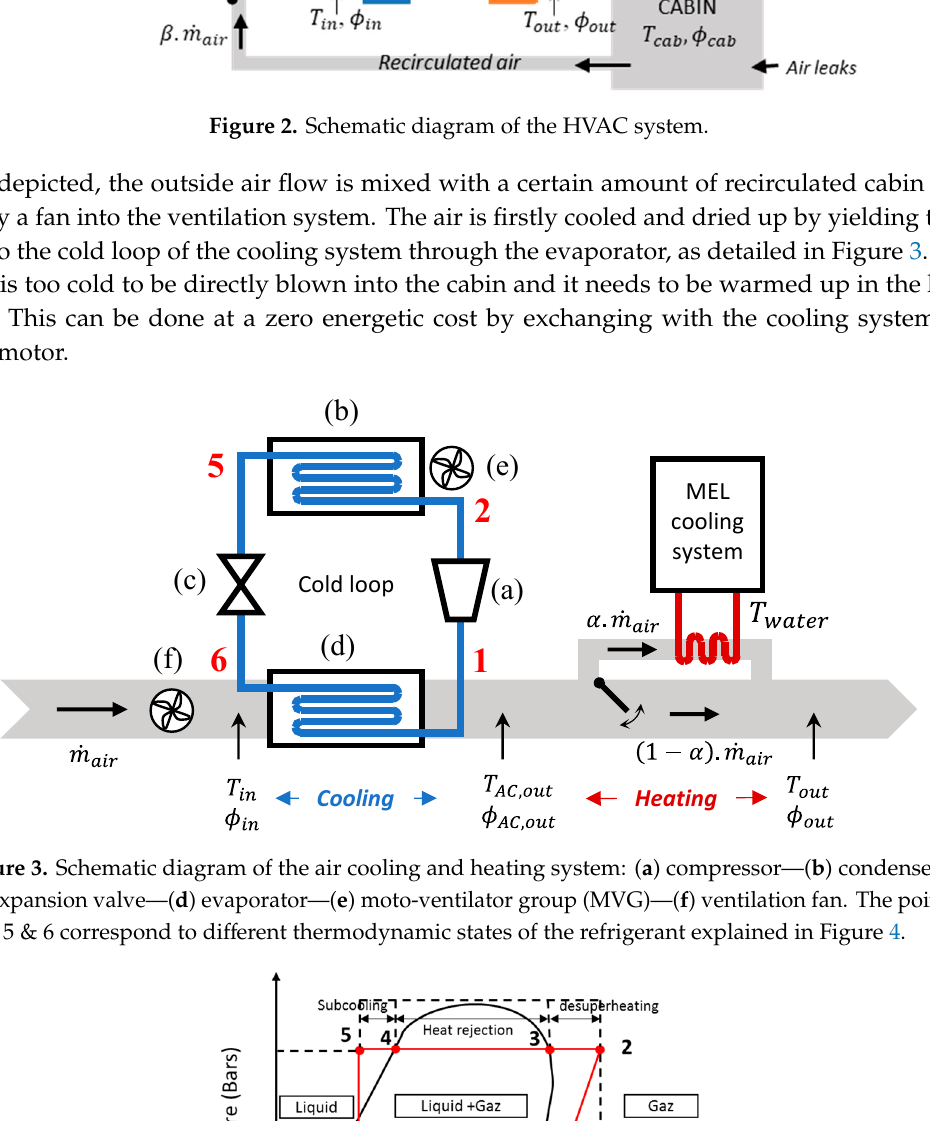
Figure 4. Refrigerating thermodynamic loop.